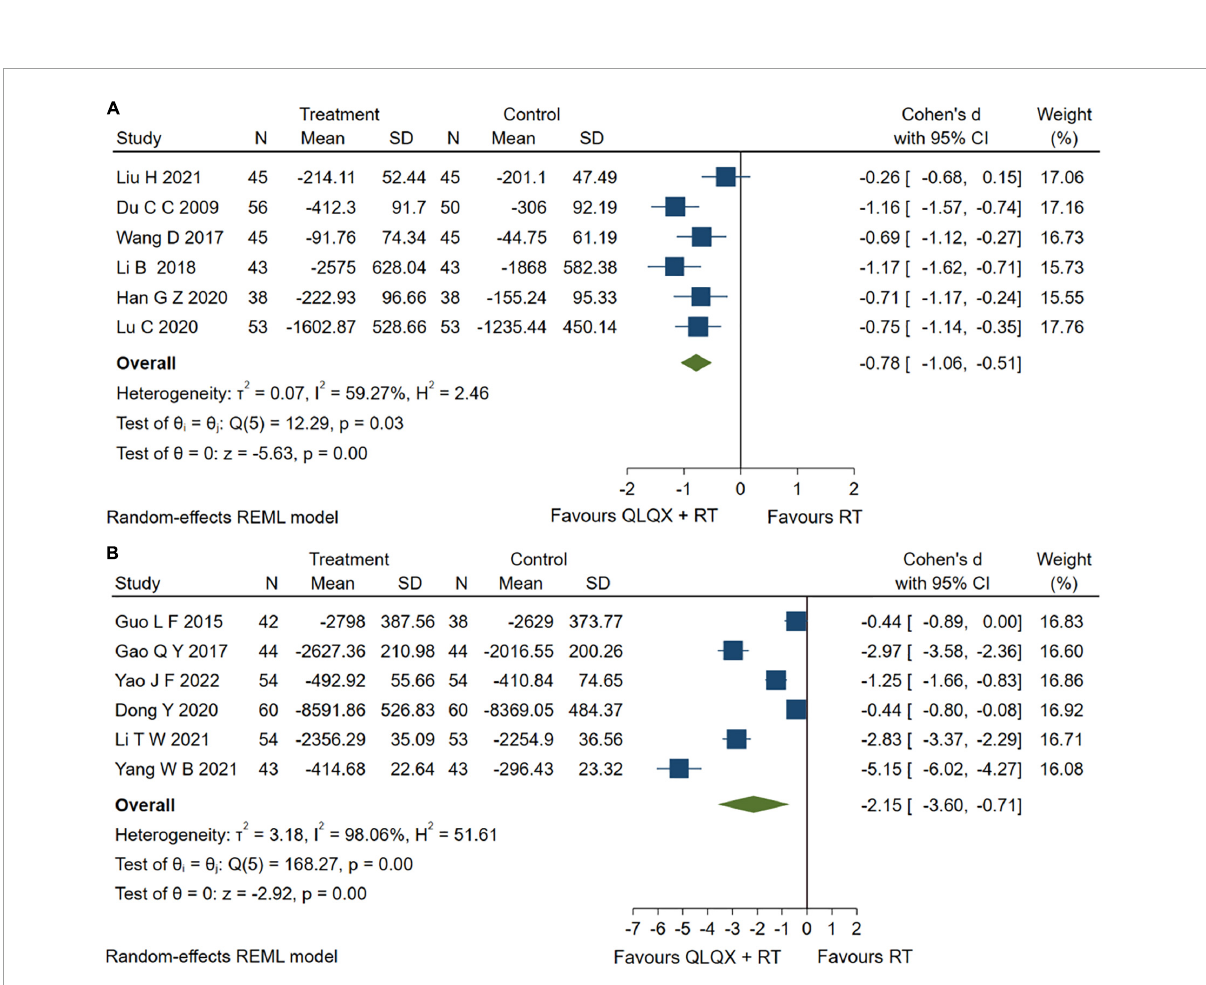
FIGURE6 (A) Forest plots of brain natriuretic peptide; (B) N-terminal pro-brain natriuretic